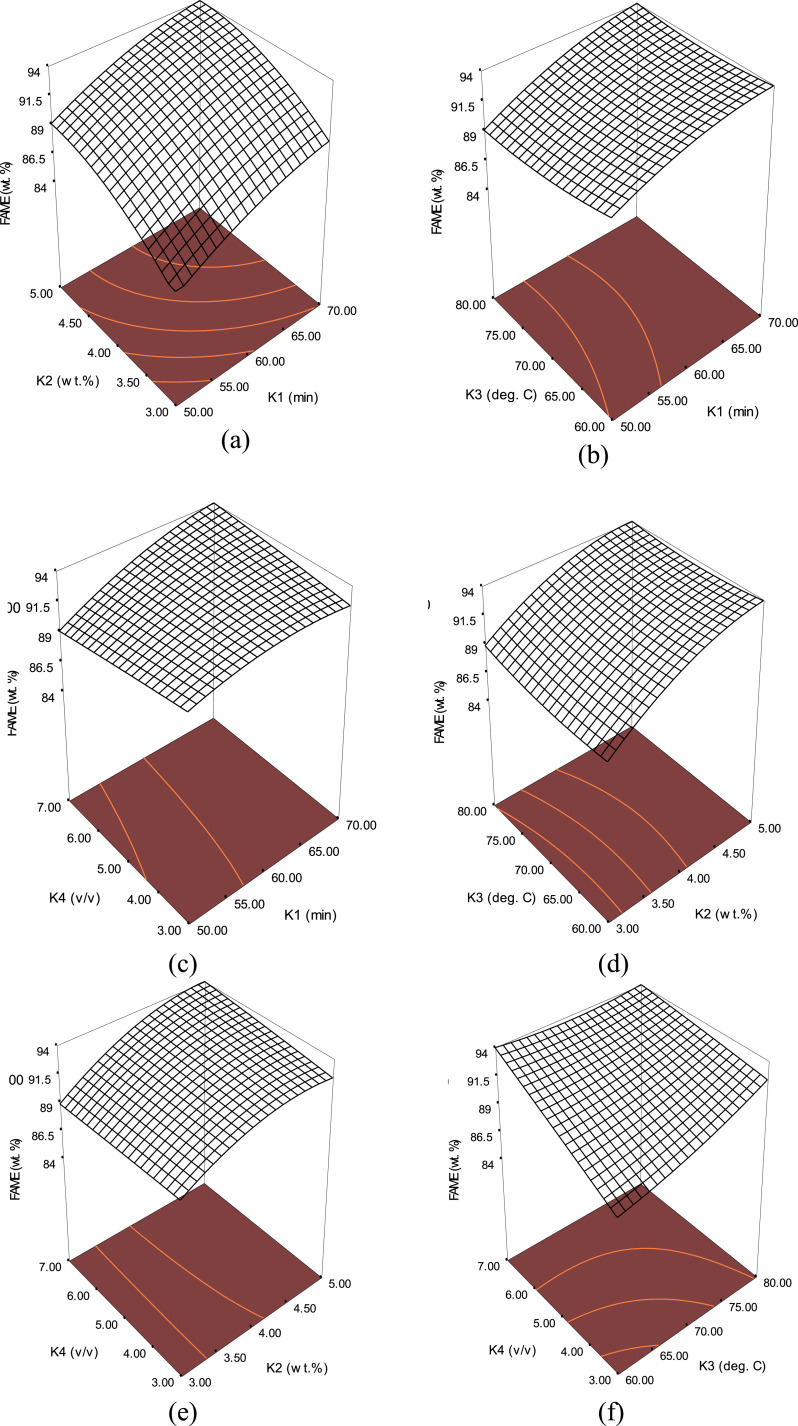
(a-f): 3-D's plots.